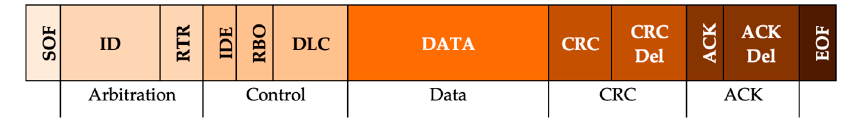
Figure 1. Controller area network (CAN) message structure.